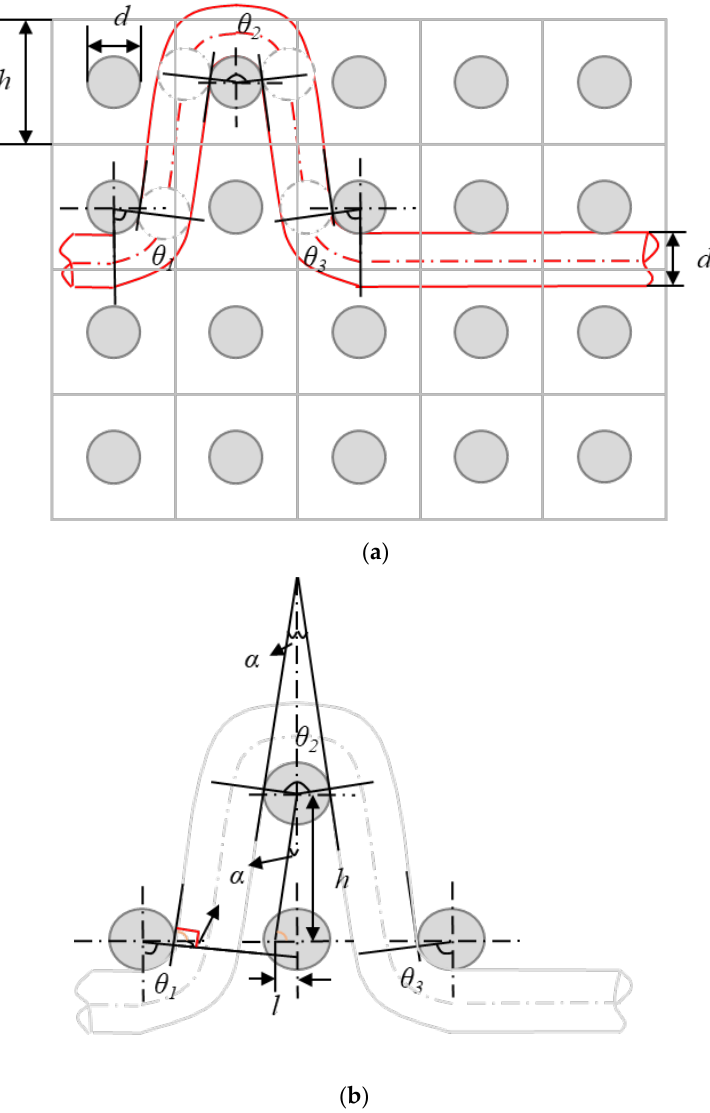
Figure 10. Schematic diagram ( a ) and geometrical model ( b ) of crimps angles ( θ ) and linking points among the warp and weft yarns in the unit cell of the F2 fabric.